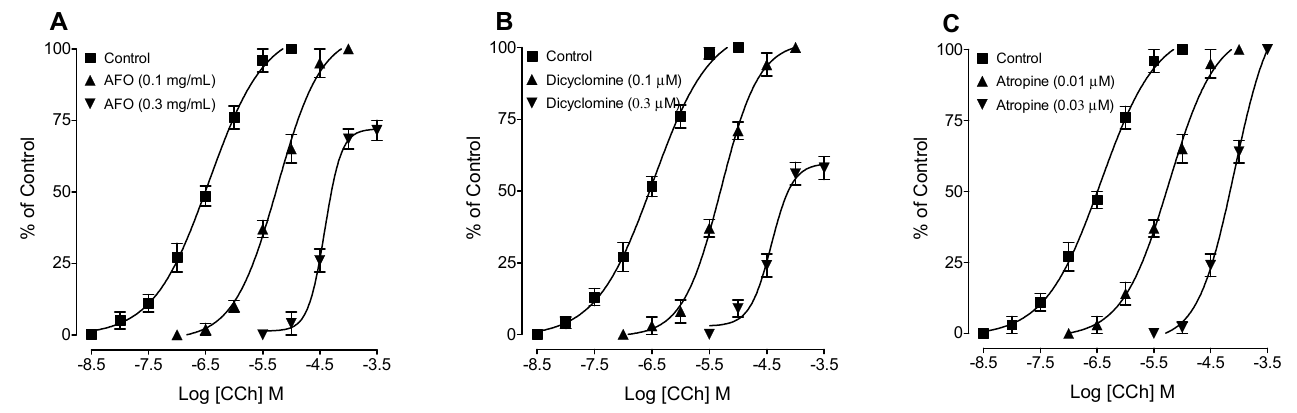
isolated guinea pig tracheal preparations. Symbols represent mean ± SEM; n = 4.